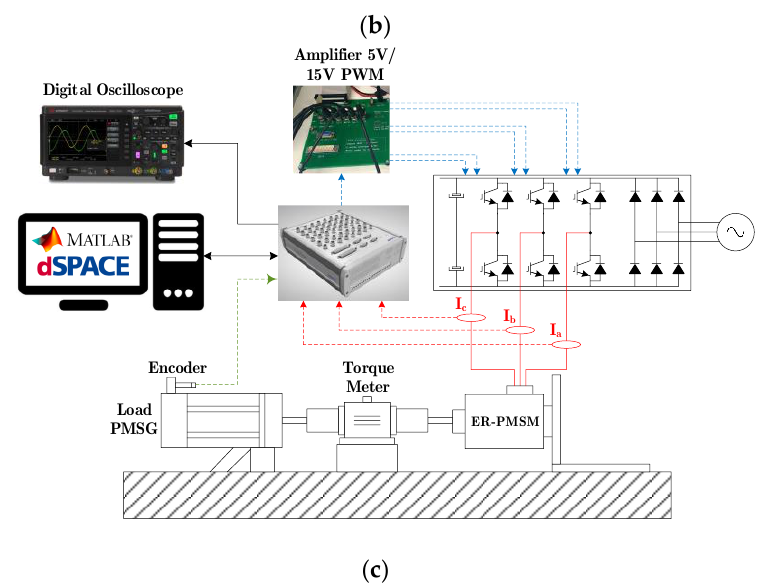
Figure 14. Experimental setup. ( a ) Global view of the test bench setup for control and diagnosis of the ER-PMSM; (1) ER-PMSM 1.5 kW; (2) torque meter T22/50 Nm; (3) load PMSG; (4) encoder; (5) MX440B module; (6) dSpace 1202 MicroLabBox; (7) MATLAB/Simulink ControlDesk platform; (8) DC power supply; (9) Semikron 3Φ inverter; (10) power supply 3Φ/50 Hz; (11) current sensors; (12) voltage sensor; (13) digital oscilloscope. ( b ) Structure of the stator winding of the ER-PMSM; ( c ) block diagram of the setup.